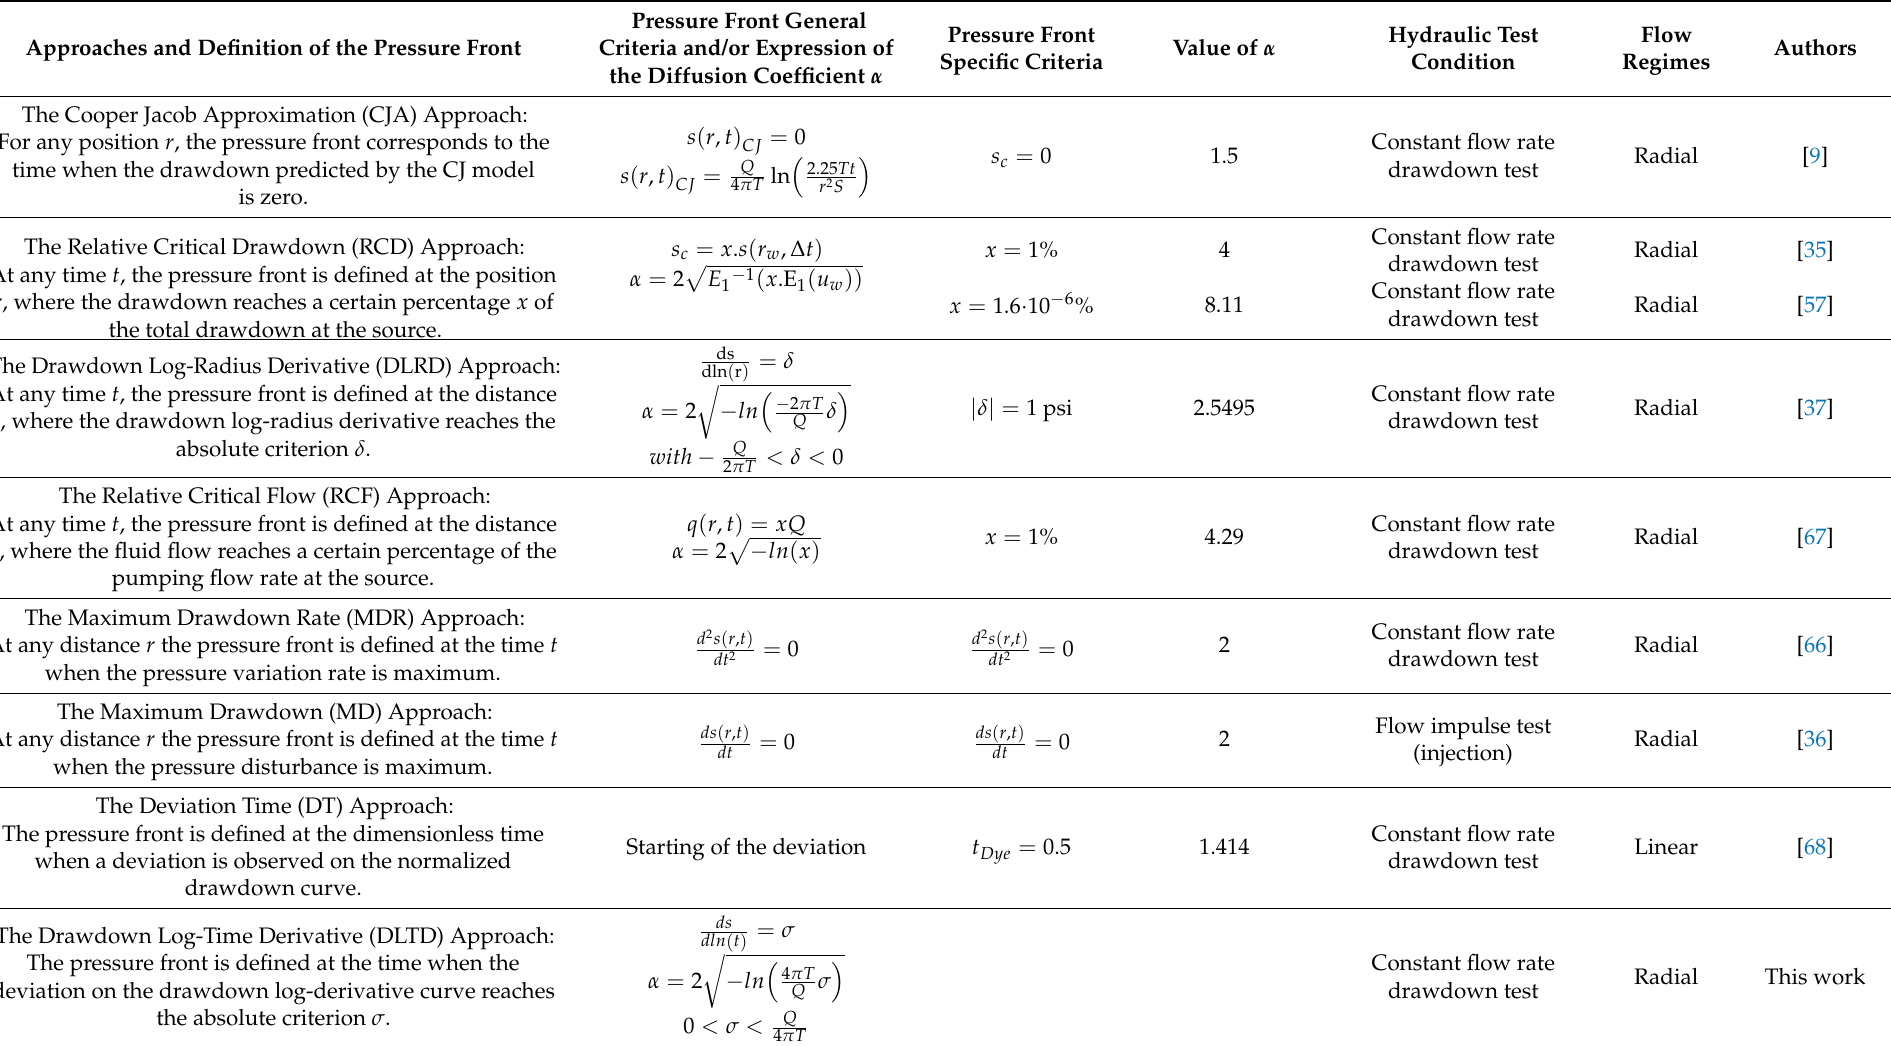
Table 1. Summary of the relevant points of the different